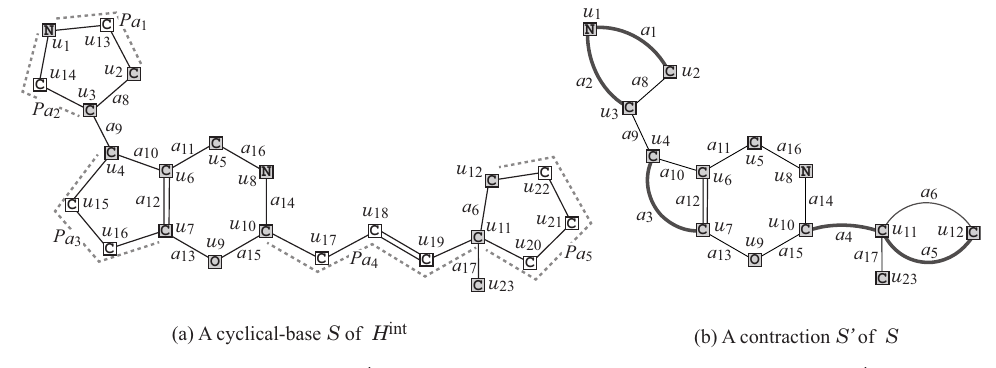
( V ( Q u ) \ { u } ) of the interior H int in Figure 4; 5 , u 18 , u 22 } } in ( a ), where a new edge obtained , P a , . . . , P a 2 5 1